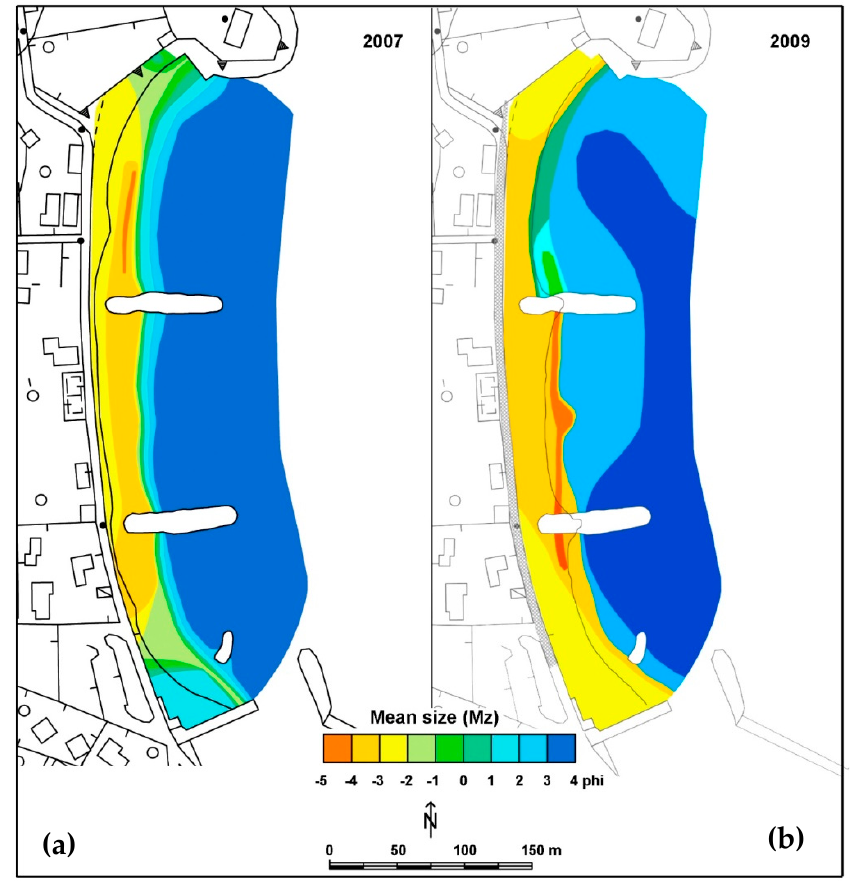
Figure 11. Sediment mean size (M z ) in June 2007 ( a ) and May 2009 ( b ).